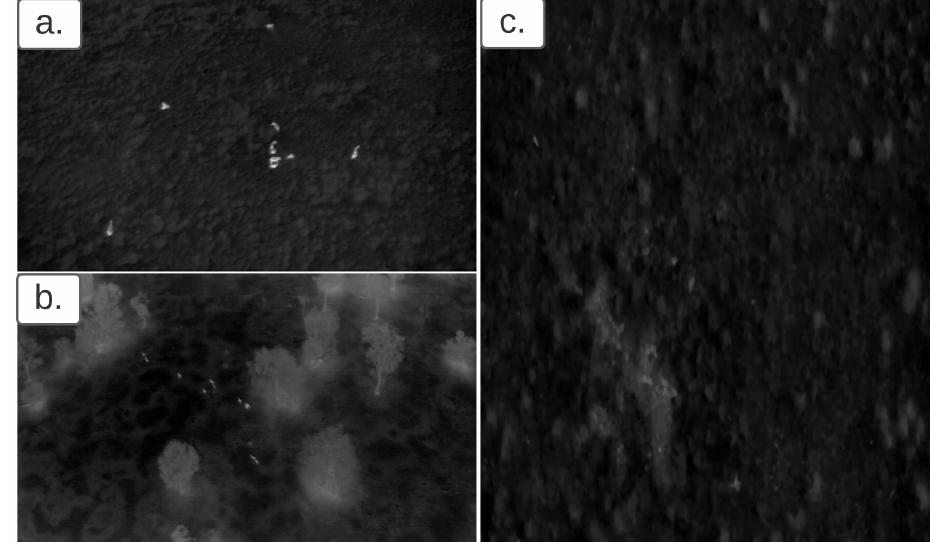
Figure 1. Larger animals (( a ) cattle, ( b ) goats) have stronger thermal imagers and greater pixels per animal than much smaller animals (( c ) rabbits—two individuals top left of the image). (Image ( a , b ) taken from footage collected on the VayuHD. Image ( c ) taken from footage collected on the Jenoptik